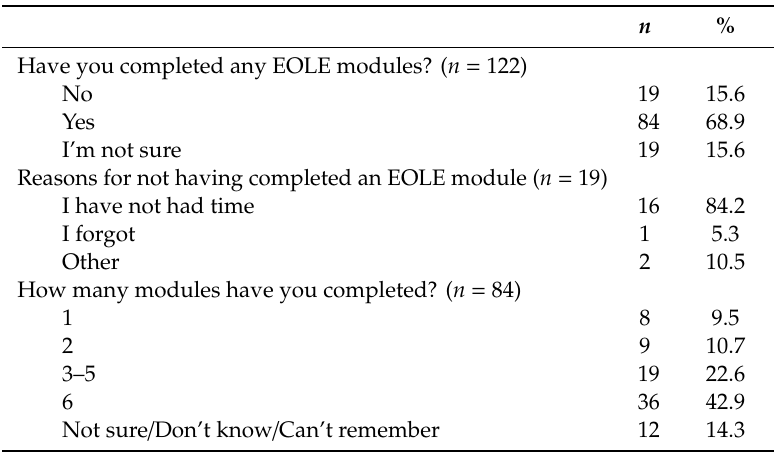
Table 1. End of Life Essentials (EOLE) module